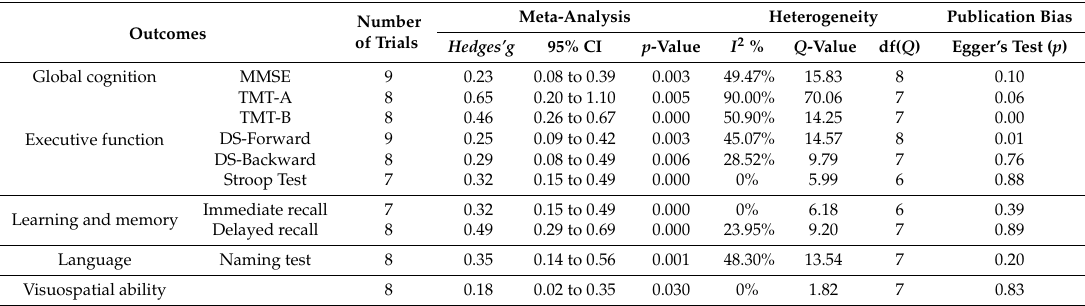
Table 3. Synthesized results for the effects of mind-body exercise vs control